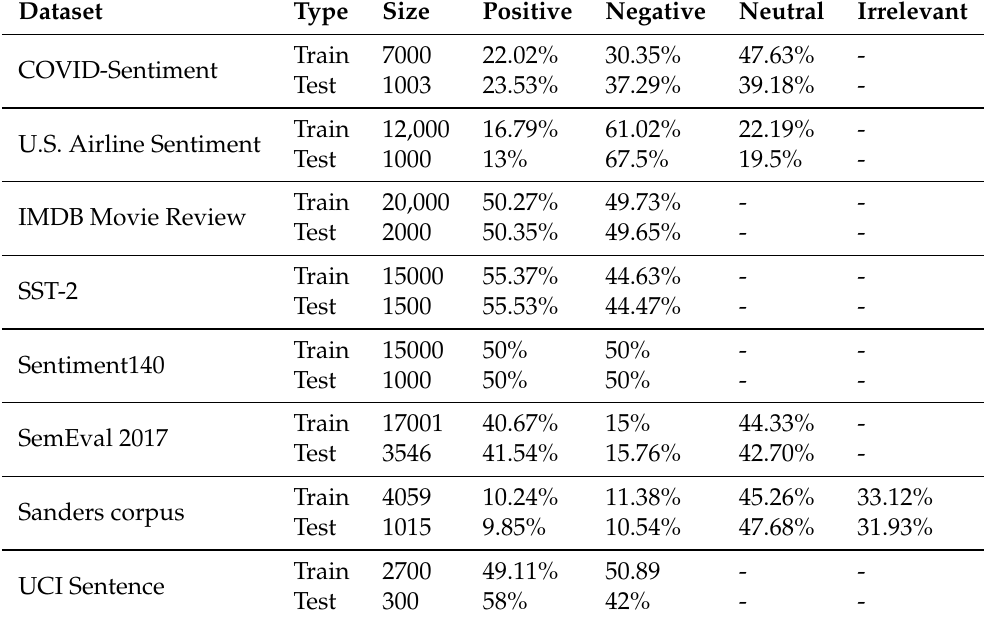
Table 1. Dataset Information.